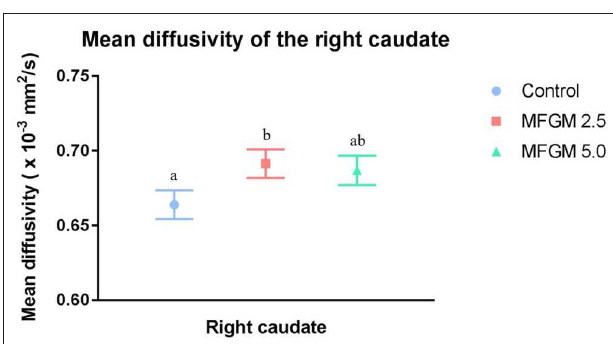
FIGURE 2 | Absolute volumes of whole brain, gray matter, and white matter in each diet (12 replicate pigs per treatment). There were no significant differences in any outcomes due to dietary treatment. MFGM, milk fat globule membrane.